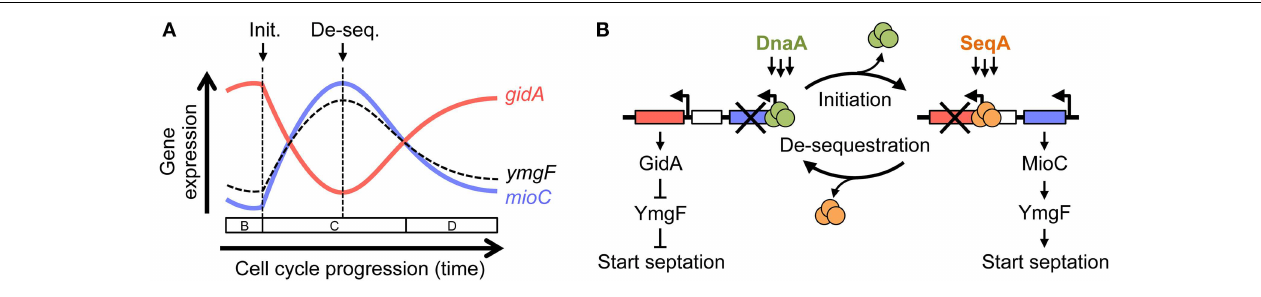
FIGURE 7 | A model for MioC and GidA-mediated linkage between replication initiation and cell division. (A) Schematic of mioC (blue) and gidA (red) transcription during the cell cycle from synchronized cell experiments (Theisen et al., 1993; Ogawa and Okazaki, 1994), and predicted expression of ymgF (dashed curve). Times of replication initiation and origin